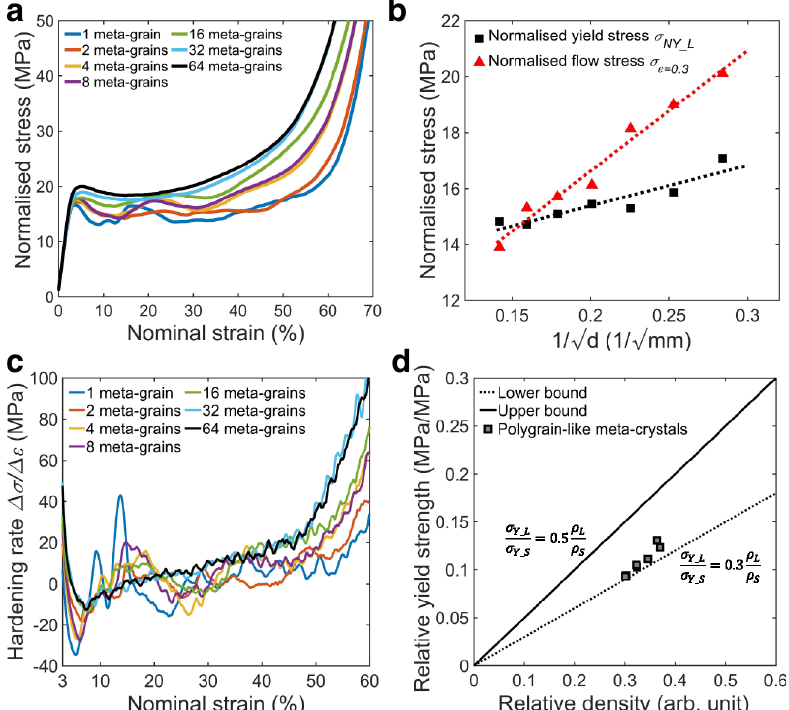
Fig. 4 Mechanical properties of lattices with different numbers of meta-grains. a Stress – strain curves. Note that stresses were normalised by the relative density of individual meta-crystals. b Relationship between normalised yield stress σ NY L , fl ow stress σ ε ¼ 0 : 3 at ε ¼ 0 : 3 and meta-grain size. c Hardening rates. d Relationship between relative yield strength and relative